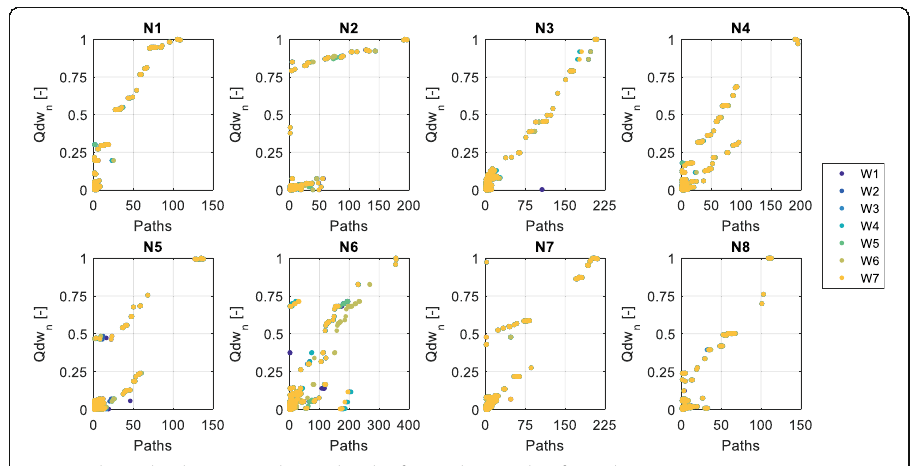
Fig. 5 Relationship between Qdw n and Paths, for 8 subnetworks of Dresden ’ s sewer system